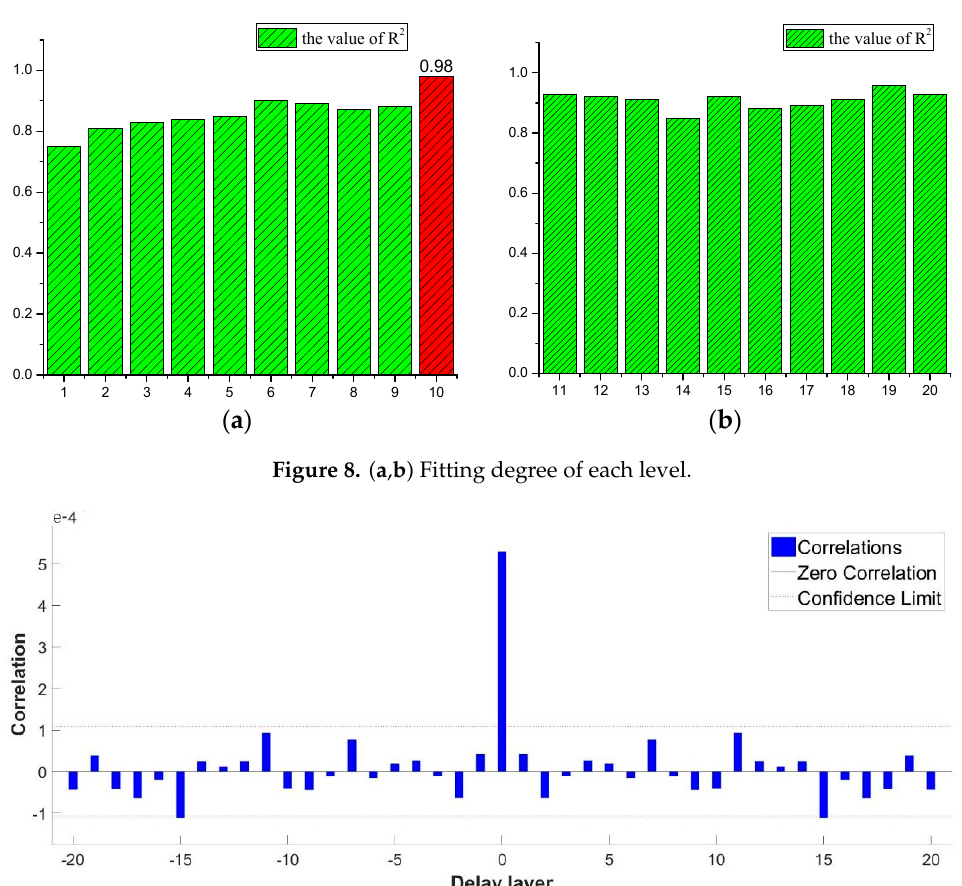
Figure 9. Autocorrelation error.